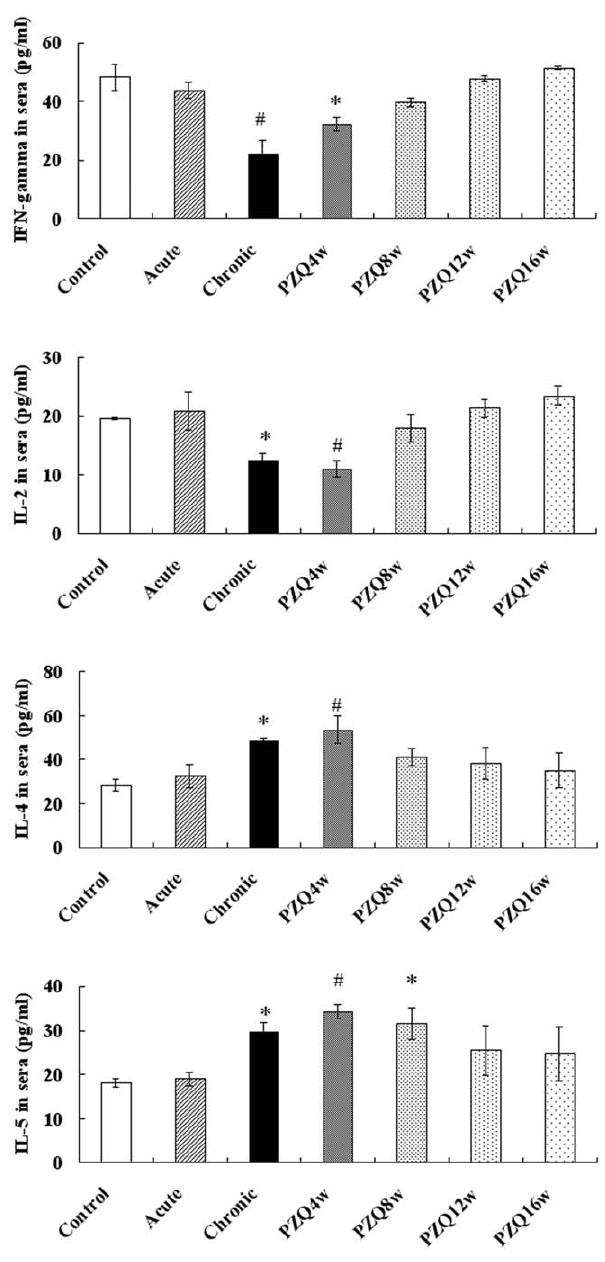
Figure 2. Th1 and Th2 cytokines in sera of mice. The levels of IFN- c IL-2, IL-4, and IL-5 were determined in individual sera (n=10 mice/ group) by commercially available ELISA kits. The experiment was performed twice and each value shown represents the mean and SE of 20 value. * P , 0.05 versus control group. # P , 0.01 versus control